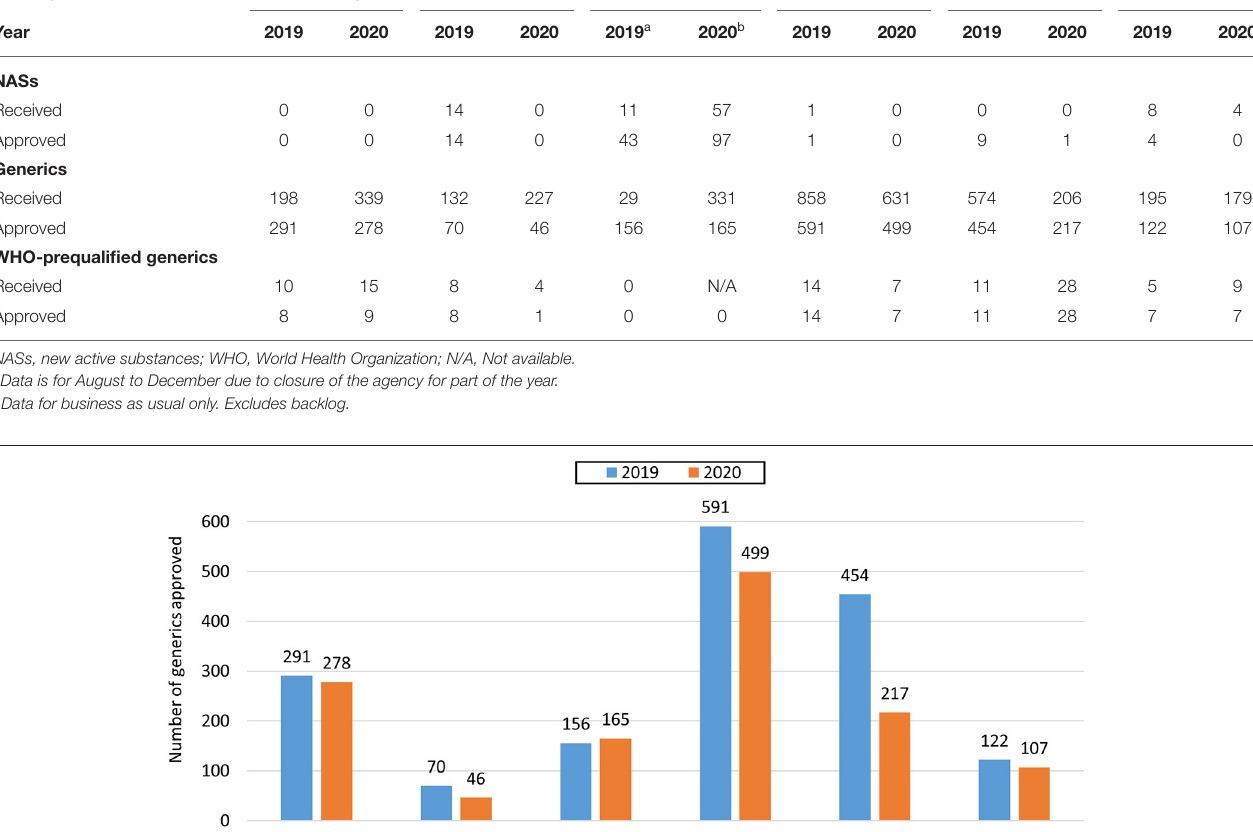
TABLE 1 | Comparison of metrics on NASs, generics, and WHO prequalified generics (2019–2020). Country